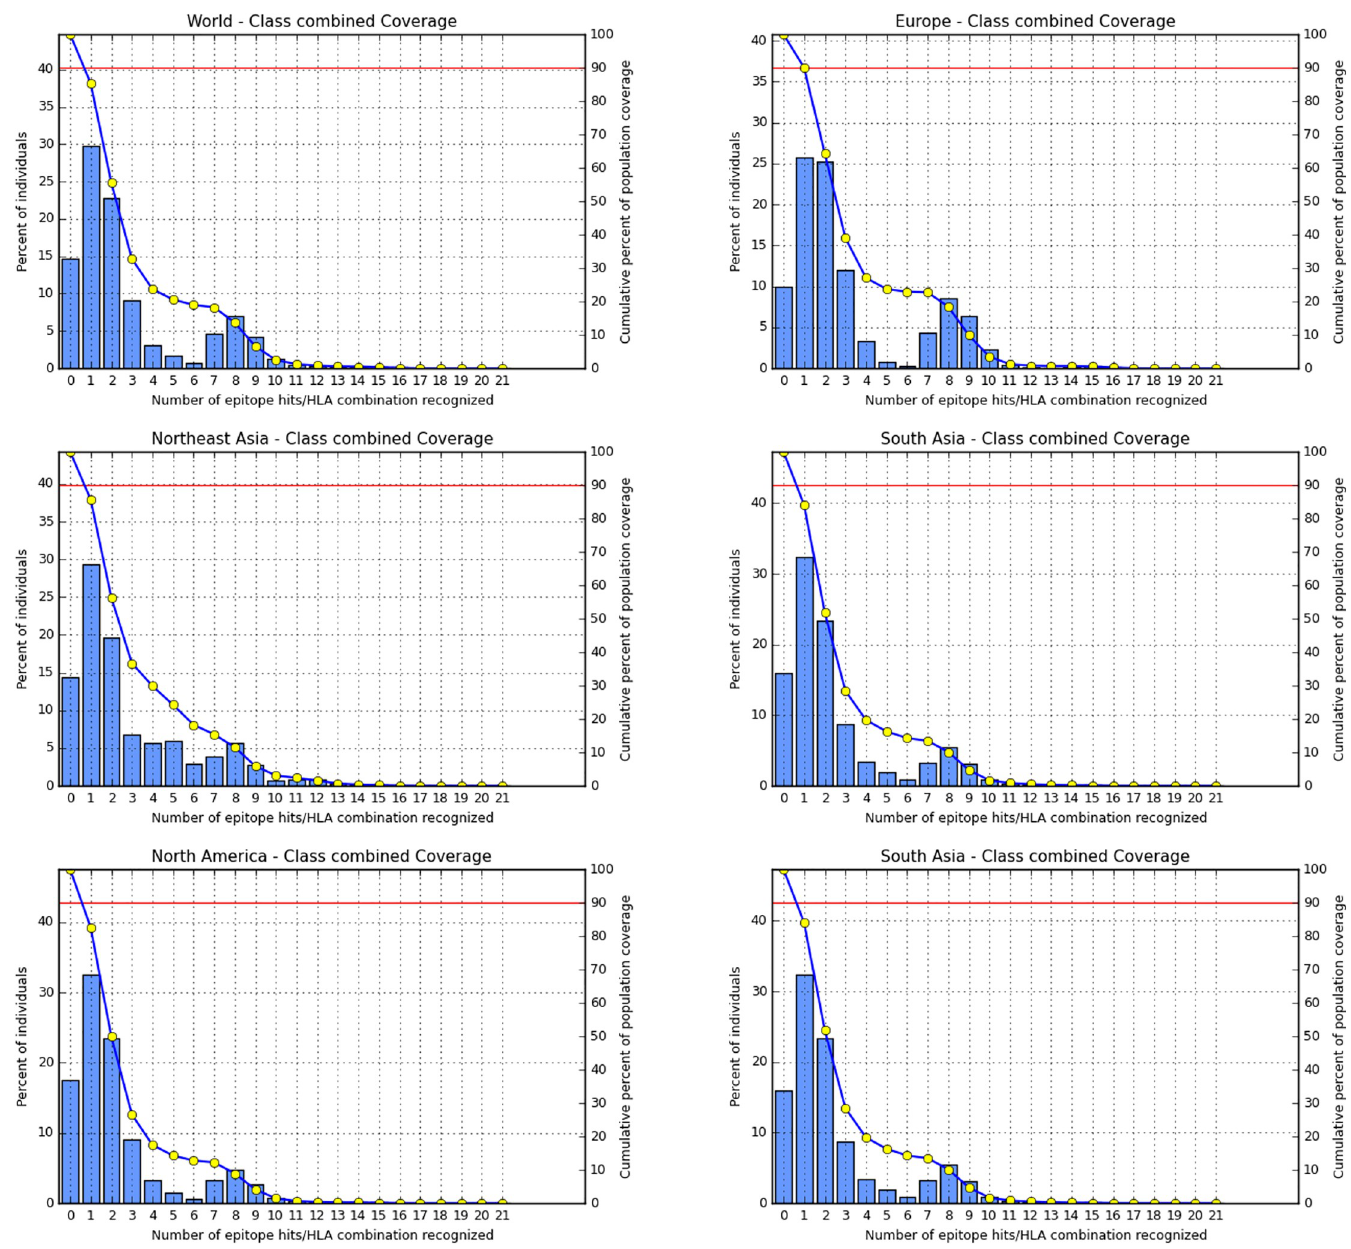
Fig 3. Population coverage data based on MHC class I restriction data. Here the line (-o-) shows the cumulative percentage of population coverage for the epitopes, and the bars represent individual population coverage of the epitopes.